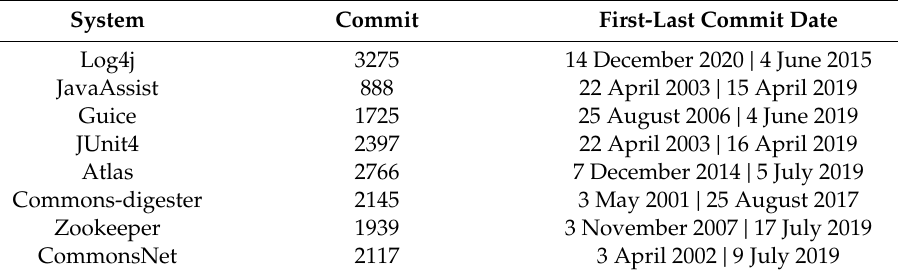
Table 2. Systems analyzed.